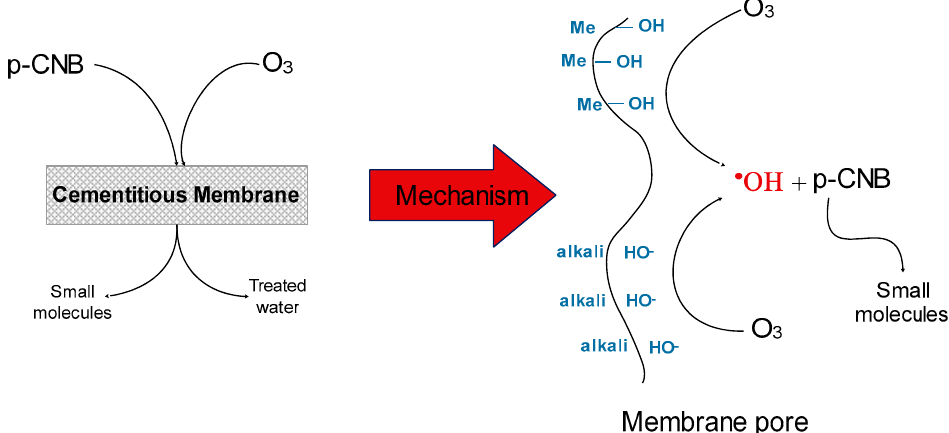
Figure 8. Main radical mechanisms regarding the removal of p-CNB by the synergistic effect of a cementitious catalytic membrane and ozone application (adapted from [48]).